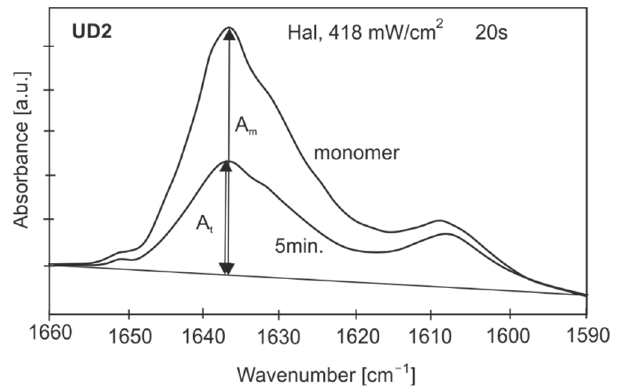
Figure 2. Absorbance changes during polymerization.